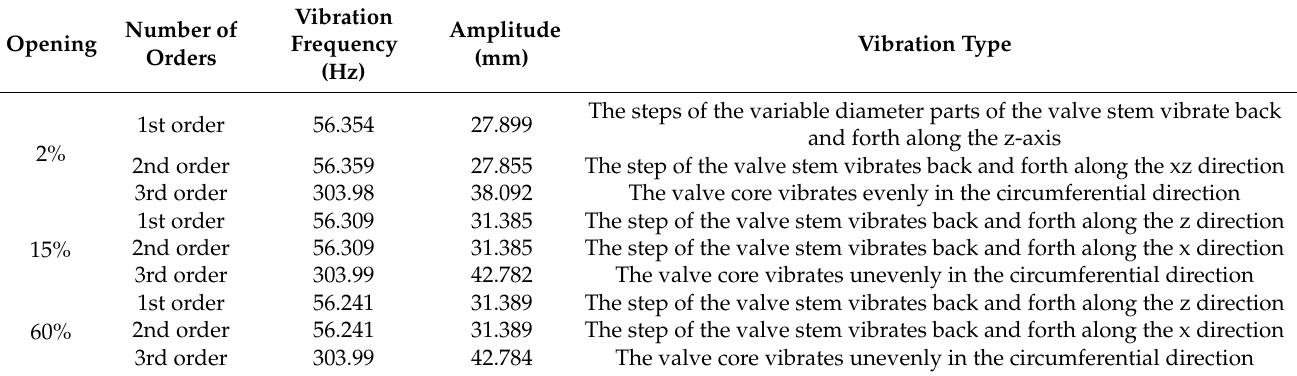
Table 5. Table of vibration modes of each order at different